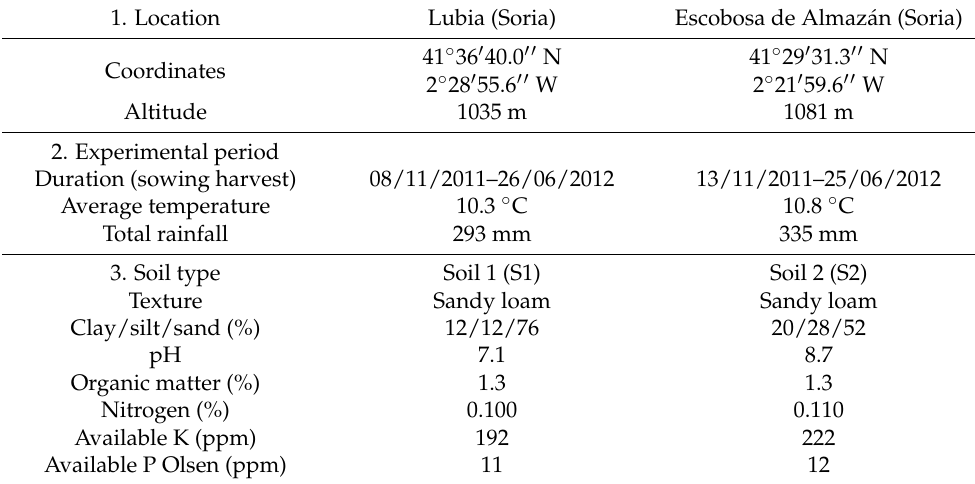
Table 1. Experimental sites characteristics and trials duration. 1.